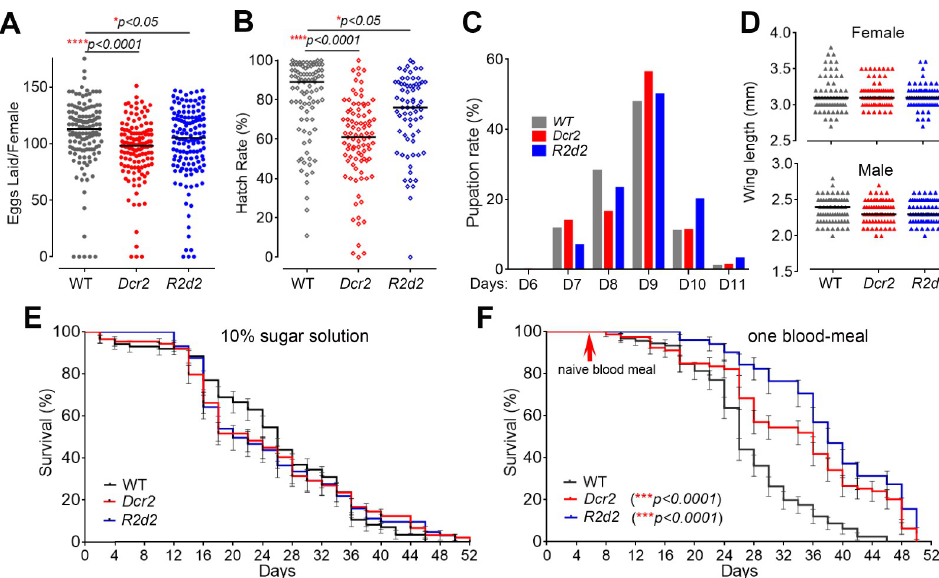
Fig 5. Fitness cost of the overexpression of Dcr2 and R2D2 in the midgut under the carboxypeptidase gene promoter ( AeCpA ) after a blood meal. CpA-Dcr2 and CpA-R2d2 transgenic mosquitoes are abbreviated as Dcr2 and R2d2 , respectively. ( A ) Fecundity of WT and transgenic Ae . aegypti , as represented by the number of eggs produced by each female mosquito. ( B ) Hatching rates of the transgenic mosquitoes’ eggs as compared to WT control Liverpool mosquitoes. Statistical analyses were performed using the Mann–Whitney test with GraphPad Prism 8 software with 3 biological replicates and 50 female mosquitoes in each replicate in (a, b). ( C ) Pupation rates of transgenic CpA-Dcr2 and CpA-R2d2 Ae . aegypti mosquitoes. Two hundred larvae in each biological replicate, at least 3 biological replicates were included. ( D ) Wing lengths as a measure of the adult transgenic mosquito body size showed no differences between female or male transgenic CpA-Dcr2 or CpA-R2d2 mosquitoes and WT adult mosquitoes. Twenty mosquitoes for each biological replicate and 3 biological replicates were included. ( E and F ) Lifespan of female mosquitoes maintained on 10% sucrose solution and those of female mosquitoes provided 1 blood meal to induce the expression of the transgenes CpA-Dcr2 and CpA-R2d2 . Statistical analyses of survival were done with the Kaplan–Meier survival test through GraphPad Prism 8 software. ��� P < 0.001. Three biological replicates were included with at least 50 female mosquitoes in each replicate. Data underlying this figure can be found in S2 Data. WT, wild